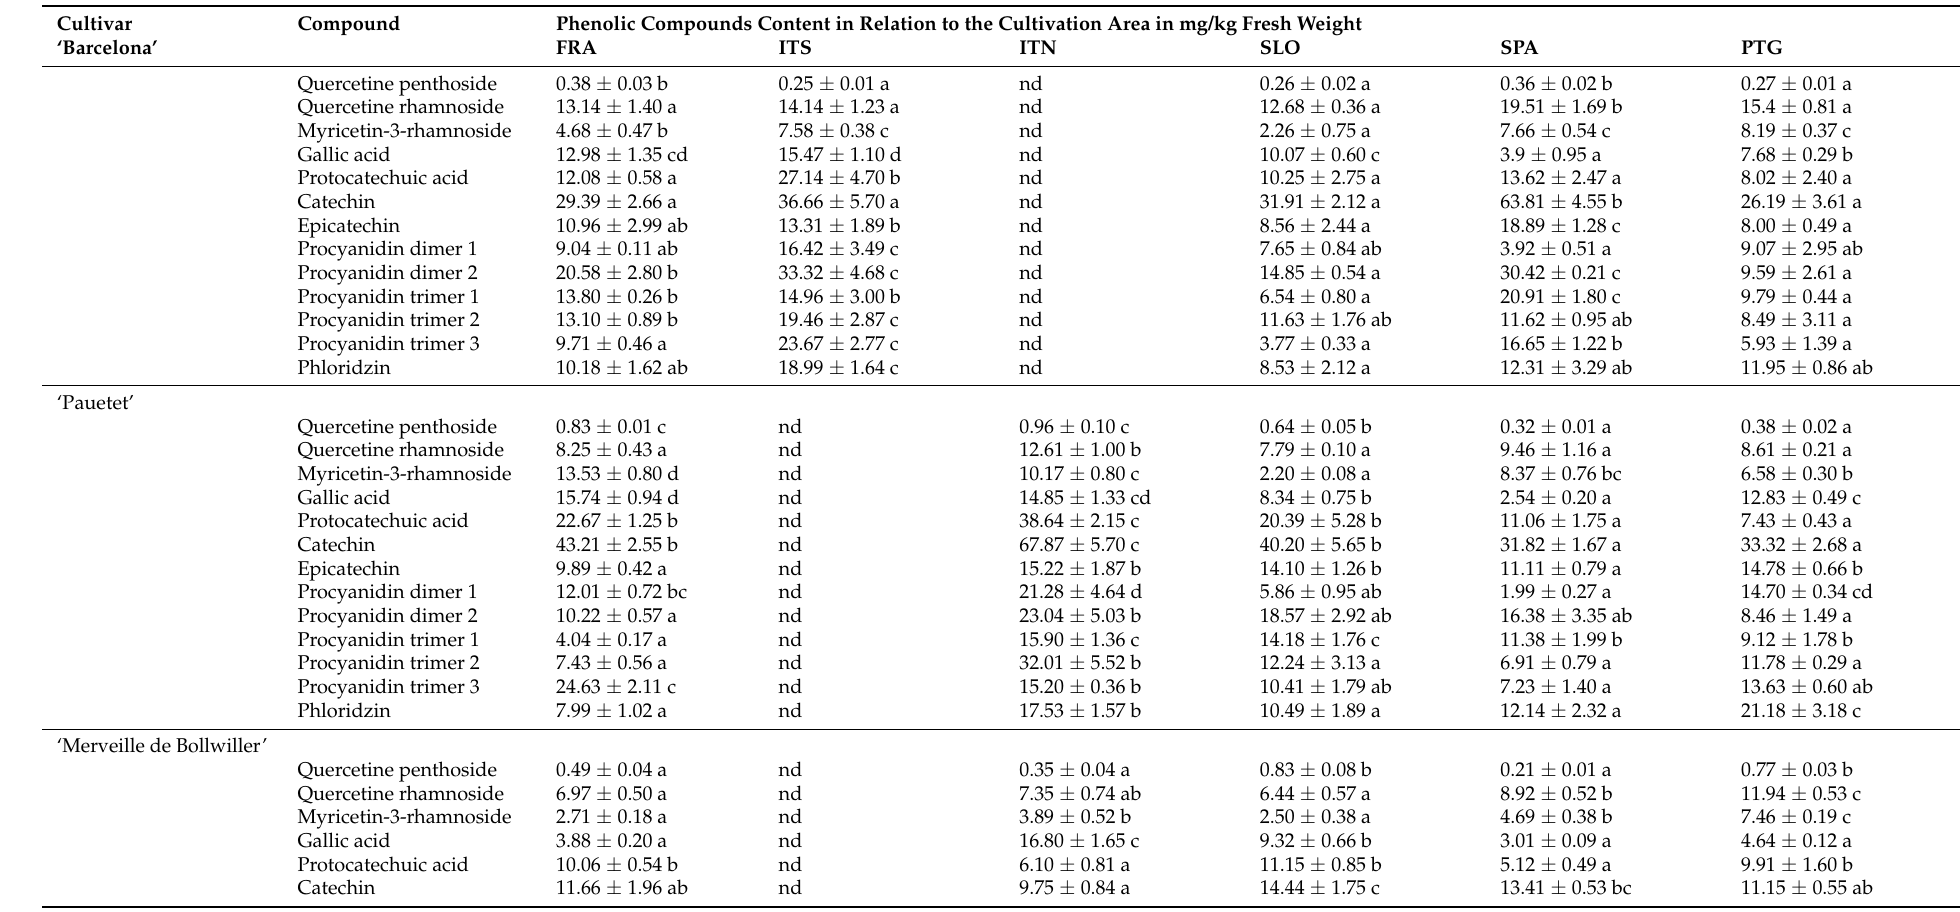
Table 2. The contents of individual phenolic compounds in hazelnut kernels cultivated in different regions of Europe.